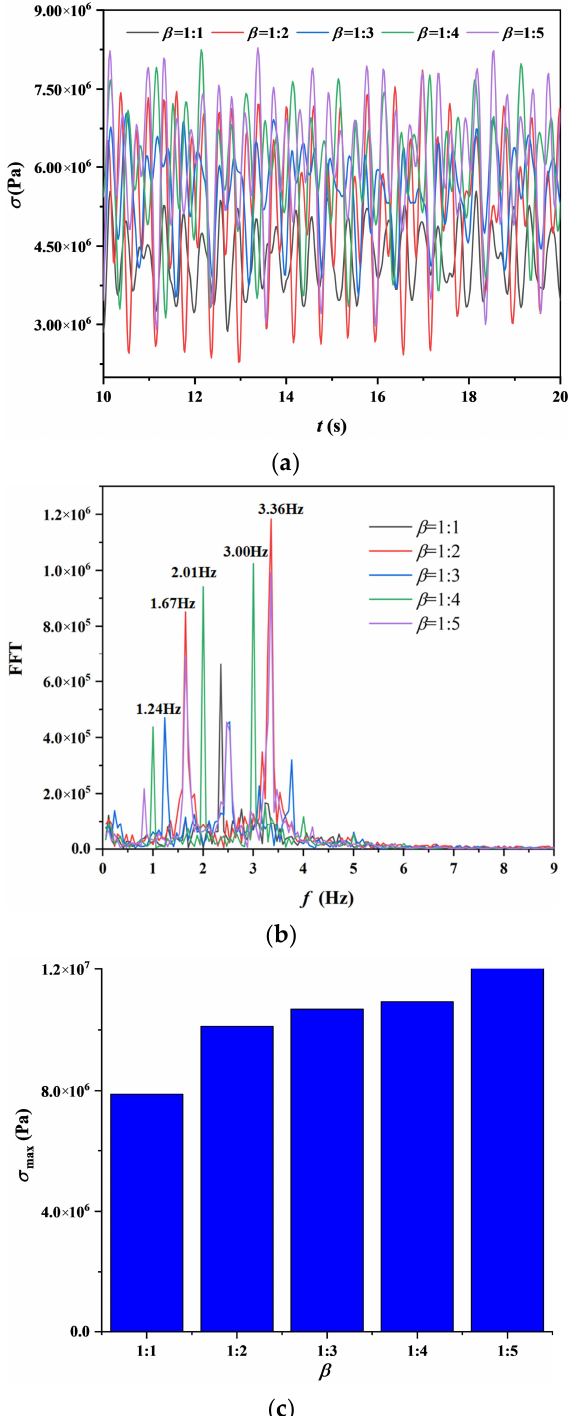
Figure 16. The stresses of Bend 5 at different gas-liquid ratios, where β is the gas-liquid ratio, σ max is the maximum stress, σ is the structural stress, f is the fluctuation frequency and t is the flow time: ( a ) time series of structural stresses; ( b ) frequency spectra of structural stresses; ( c ) comparison of the maximum stress.